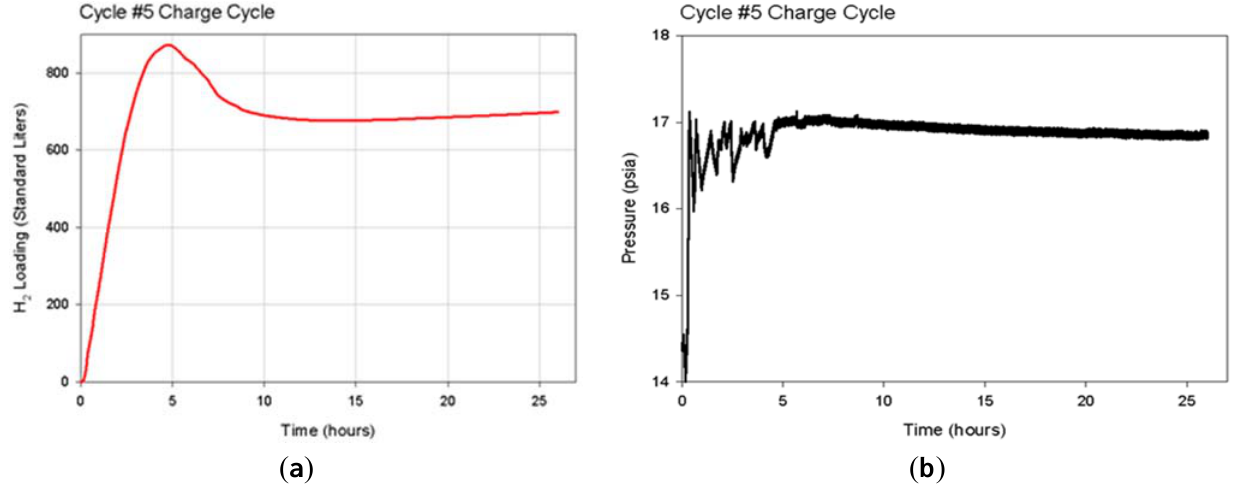
Figure 20. ( a ) Hydrogen loading with time and ( b ) hydrogen pressure with time for the fifth charge cycle (cycle